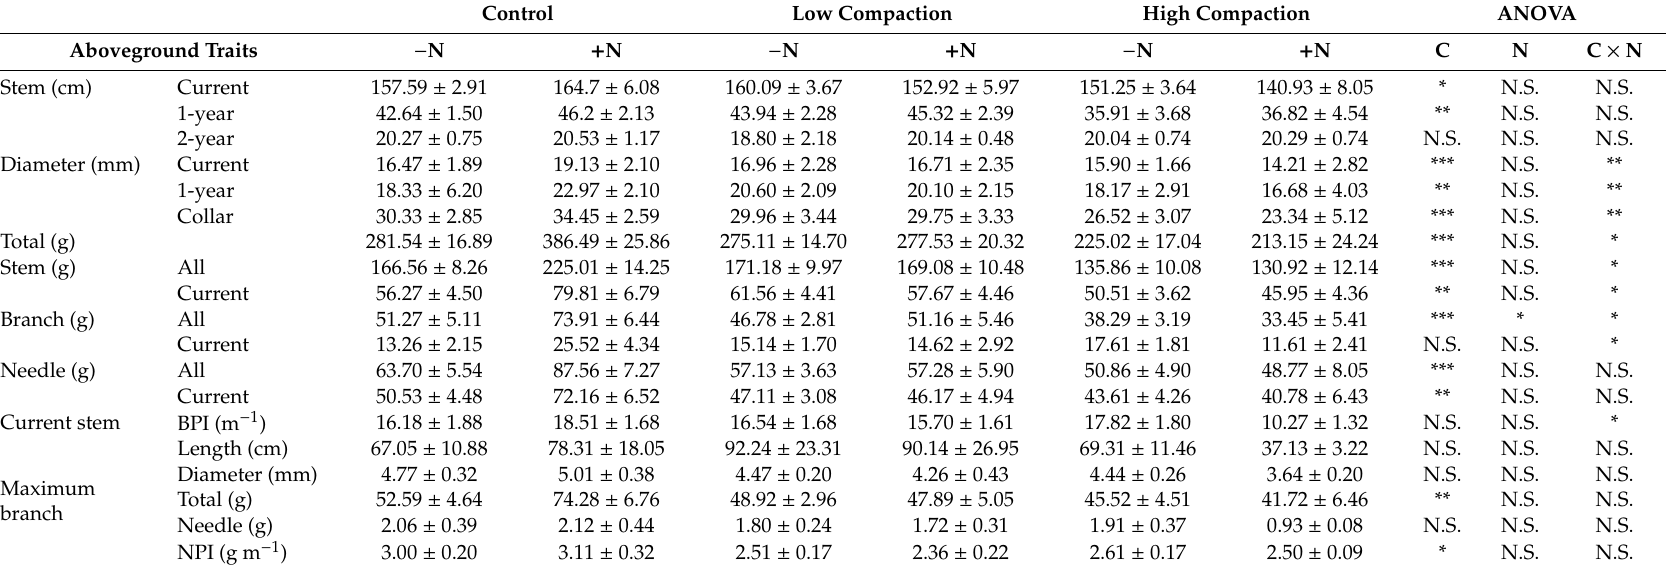
Table 1. Mean value ± SE of aboveground trait responses to soil compaction without N loading ( − N) and with N loading ( + N) and results of ANOVA (Compaction: